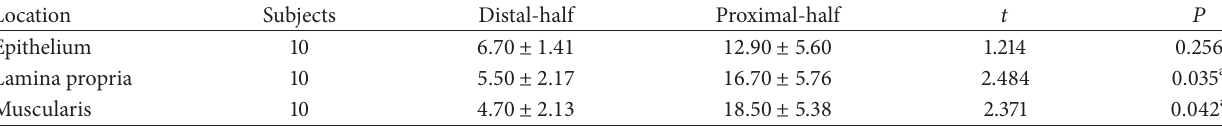
Table 2: Index of the percentage of vaginal ER 𝛼 -immunoreactive cells according to location in sham rats ( 𝛼 = 0.05 , two-tailed).